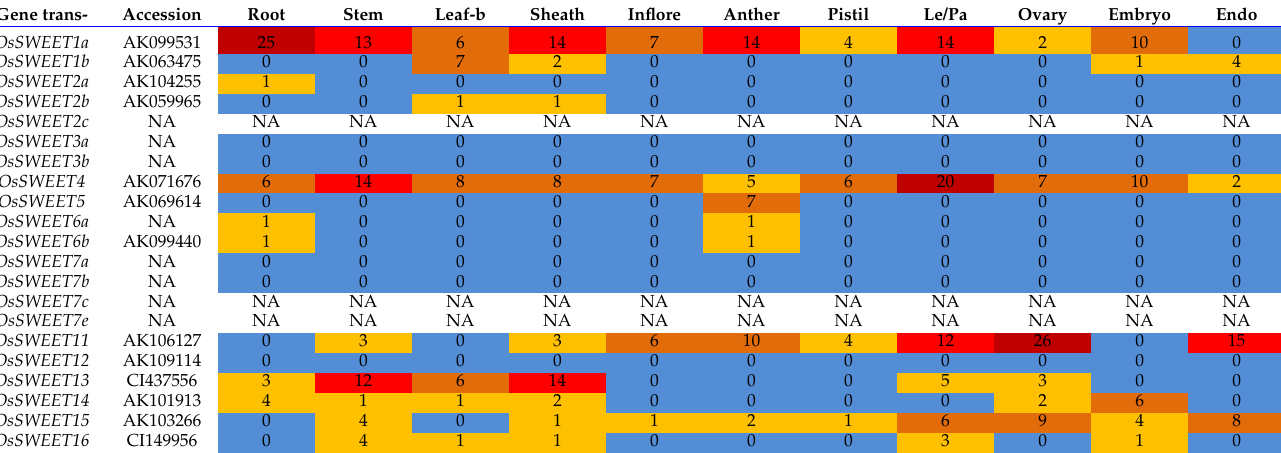
Red squares represent strong expression; brown squares represent medium expression; yellow squares represent weak expression; blue squares represent no or only marginal expression. Numbers in squares represent relative intensities of gene expression. Leaf-b: leaf blade; Infore: inflorescence; Le/Pa: lemma/palea; Endo: endosperm. NA: data not available. Hyphenated and numbered genes denote different